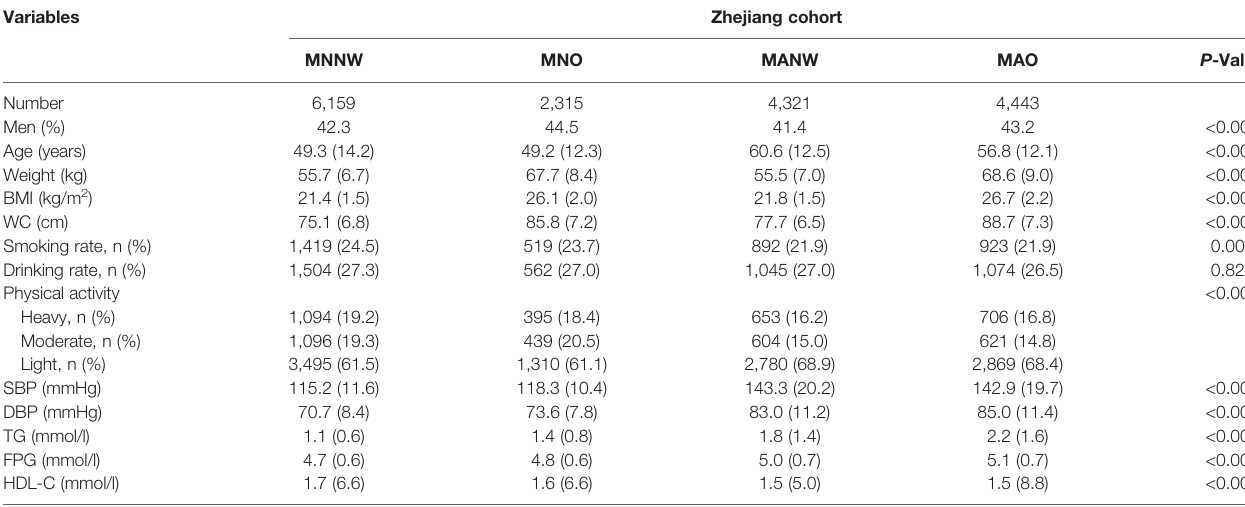
TABLE 1 | Baseline characteristics of subjects in the Zhejiang cohorts. Variables Zhejiang cohort MNNW MNO MANW MAO P -Value